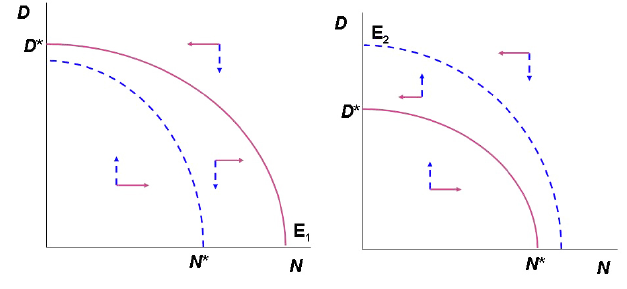
Fig. 7. Dynamics of harvested wild and domestic Rangifer populations with autocorrelated random, simple combined density-dependent recruitment (r). In this example, K = 100, wild and domestic r, n r, and r are the same, respectively, as in Figs. 4 and 5, and correlation of 0.45 for wild and domestic random r.